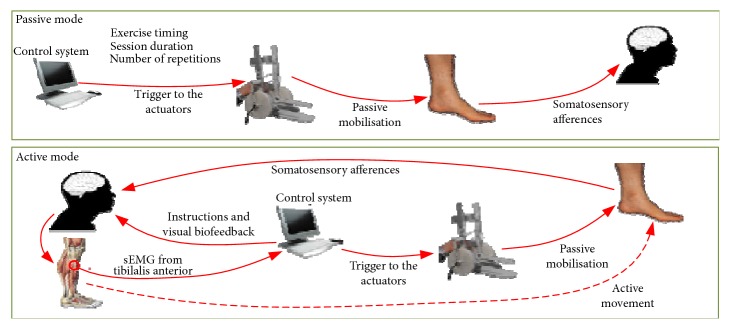
Passive and active control modes [88].